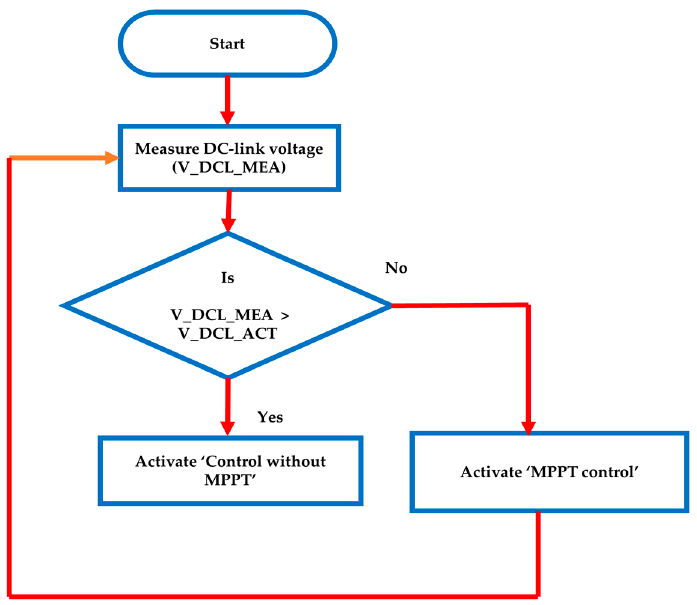
Figure 5. Flowchart showing operations of the proposed DC-link control scheme.